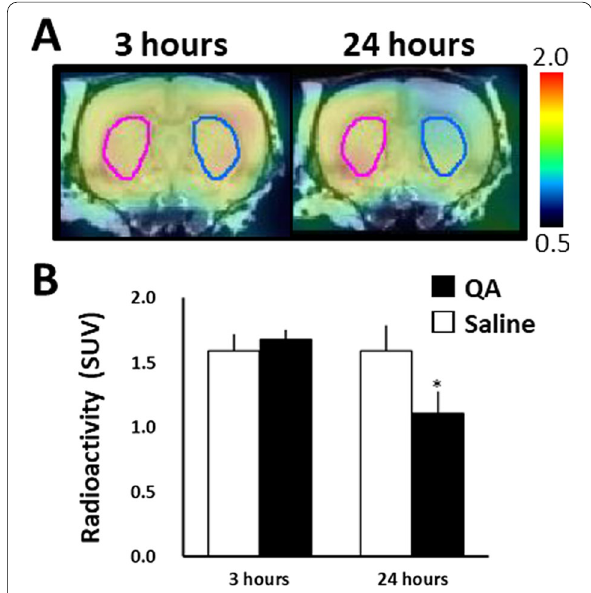
Fig. 3 18 F-BCPP-EF uptake at 3 h and 24 h after QA injection. QA was injected into the striatum on the right side of the image, and saline was simultaneously injected into the contralateral striatum. A PET images of 18 F-BCPP-EF uptake in QA-injected rat brains were superimposed on the MRI atlas images. PET scans were performed for 90 min with 18 F-BCPP-EF, 3 h and 24 h after QA injection. Summation PET images from 45 to 60 min were reconstructed to obtain standardised uptake value (SUV) images. B Radioactivity concentrations for the time period from 45–60 min (SUV). The VOIs were identified based on the whole striatum. Mean * P < 0.05, between the saline- and QA-injected sides using